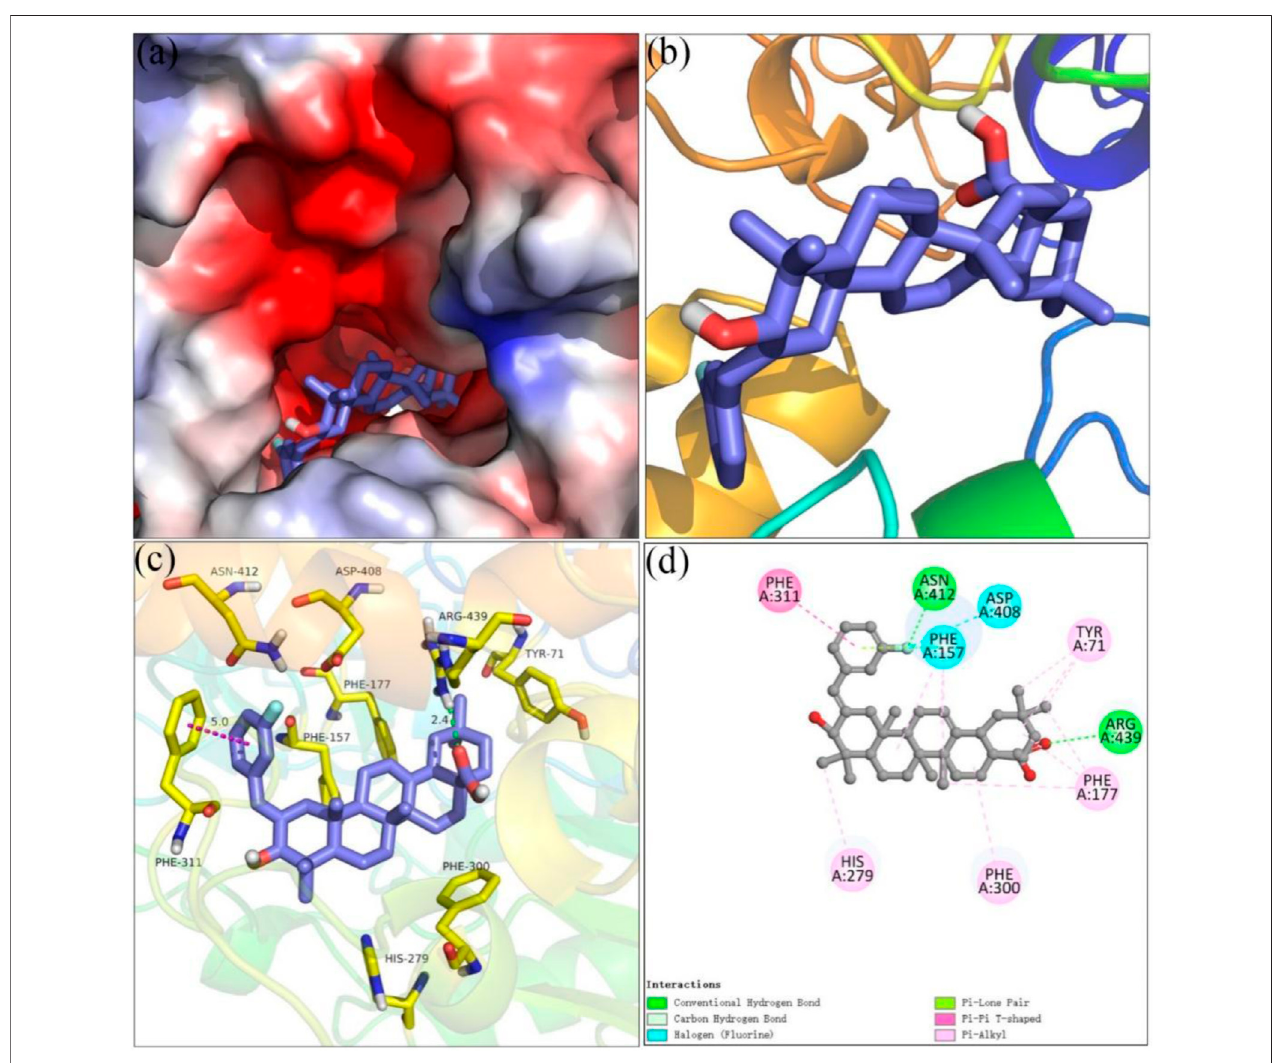
FIGURE 3 | Molecular docking of analog 4i with α -glucosidase. (A) 4i in the electrostatics active pocket; (B) 4i in the active pocket; (C) 3D view of 4i with α - glucosidase; (D) 2D view of 4i with α -glucosidase.